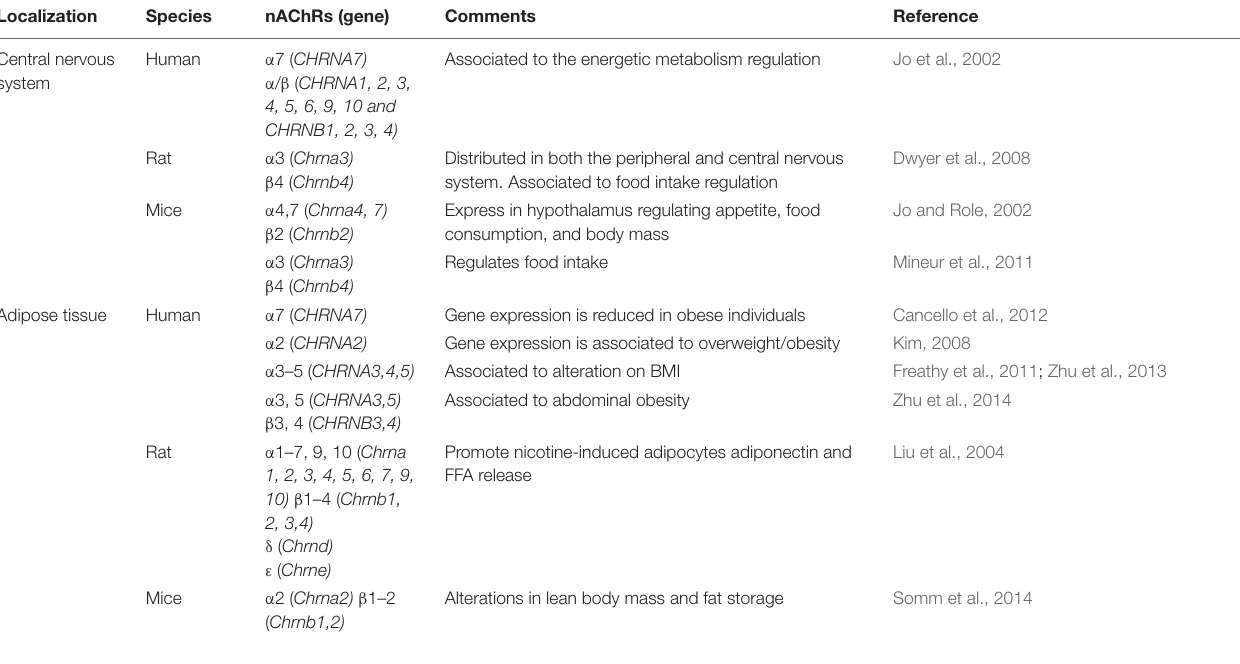
TABLE 3 | Characterization of nAChRs associated to